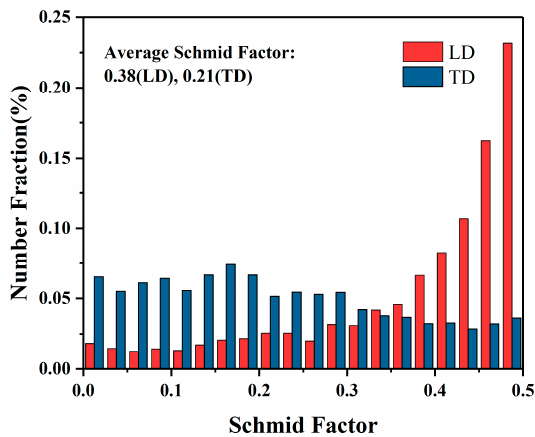
Figure 10. ( a ) Microhardness distribution along the deformation routine and ( b ) tensile stress–strain curves obtained from LD and TD specimens. Materials 2019 , 12 , x FOR PEER REVIEW